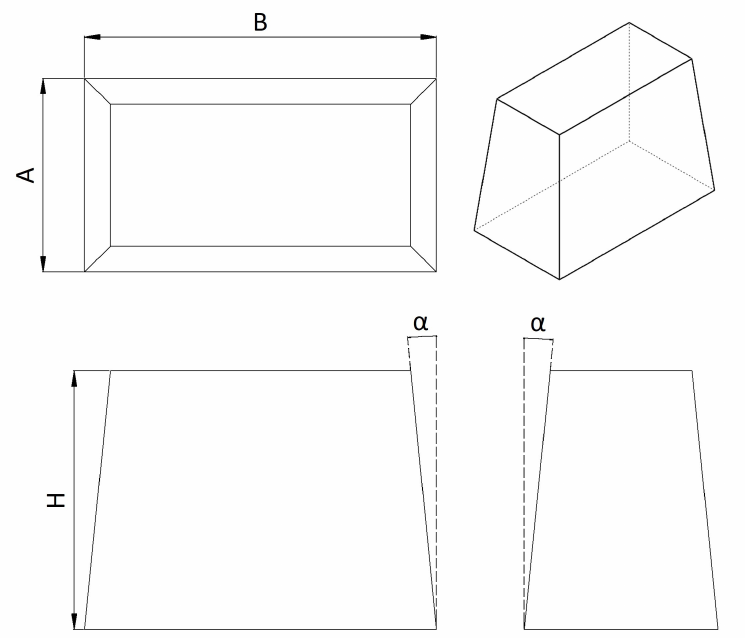
Figure 2. Solid Cube Dimension Reference.